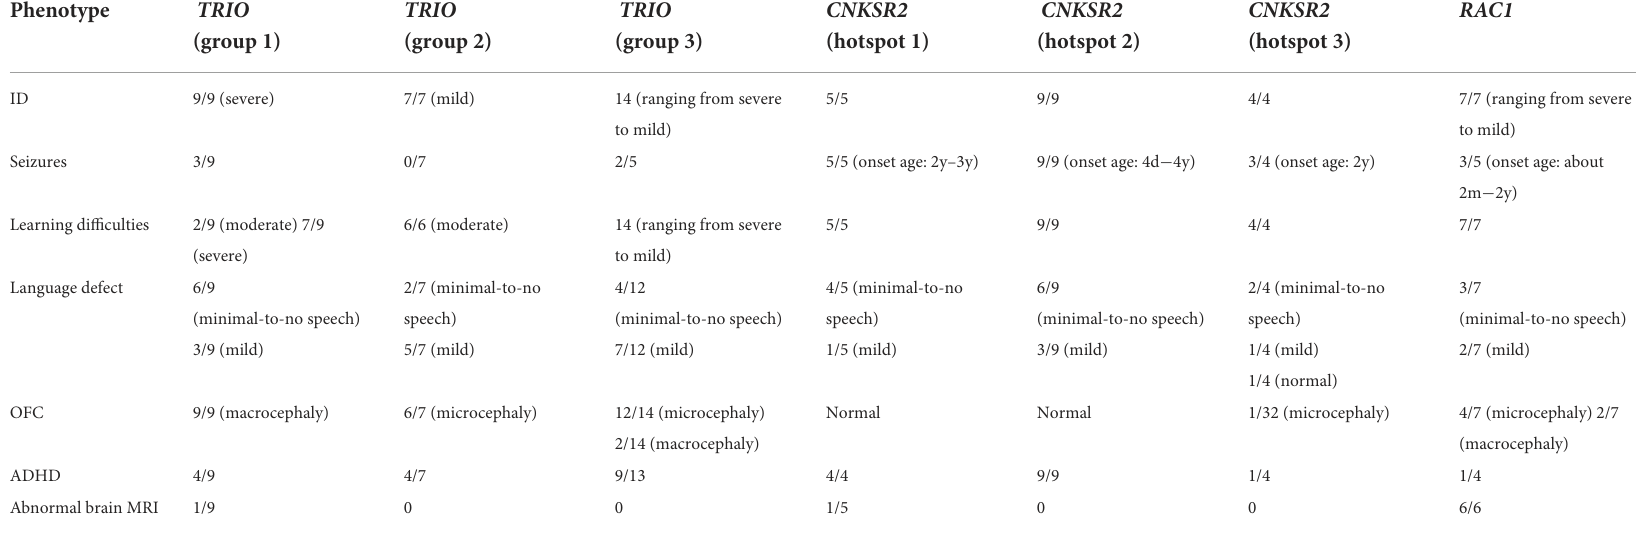
TABLE 2 The comparison of clinical manifestations among TRIO , CNKSR2 , and RAC1 variation